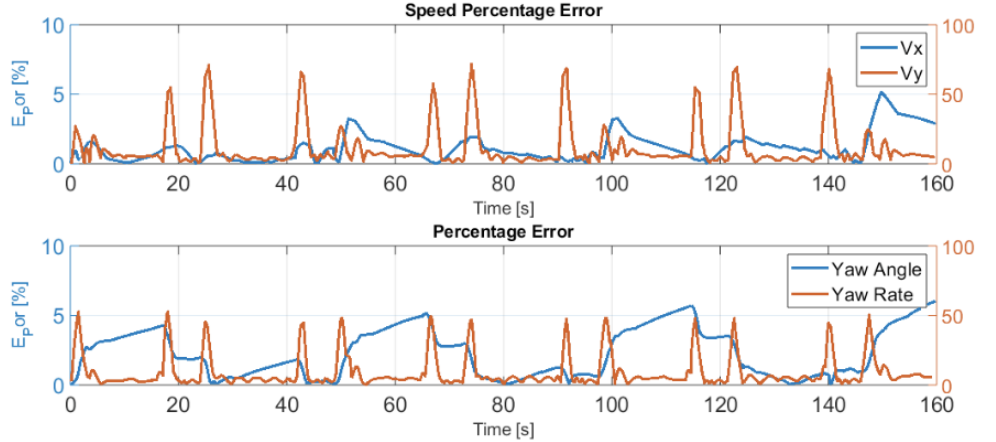
Figure 20. Static speed profile results after sensitivity test (error percentage).